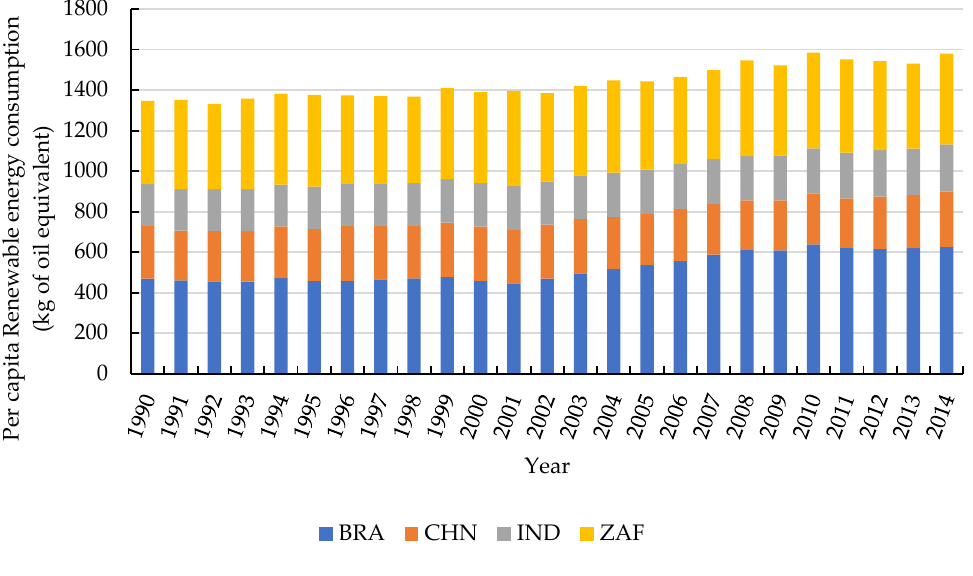
Figure 3. Per capita renewable energy consumption trends of the BRICS countries from 1990 to 2014. (Source: World Bank. BRA stands for Brazil, CHN stands for China, IND stands for India, ZAF stands for South Africa.)